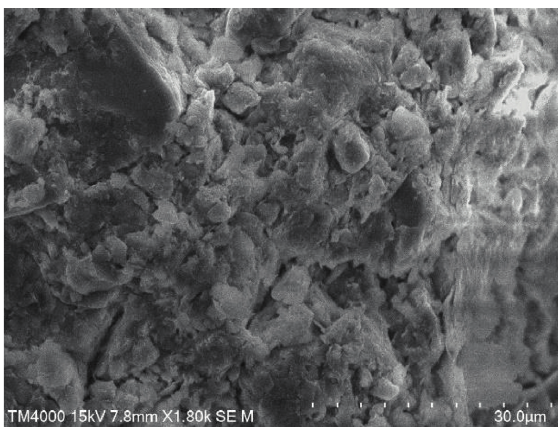
Figure 11: Plain soil (1.0k times).